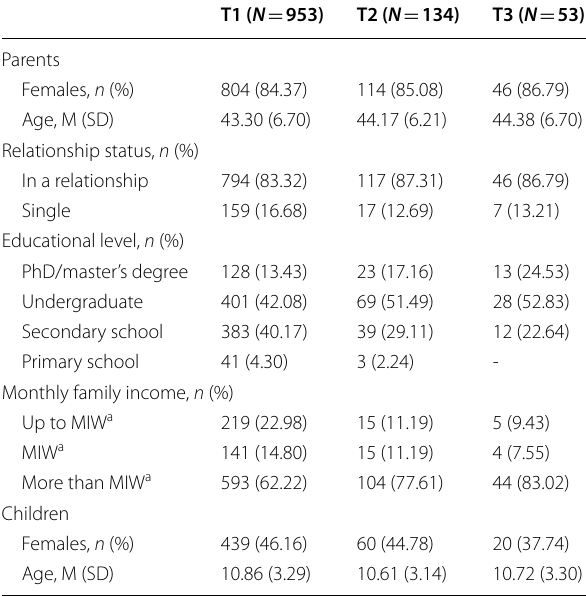
a Minimum interprofessional wage (MIW), established by the Spanish government. In 2020, the MIW was 950 € . In 2021, the MIW was 965